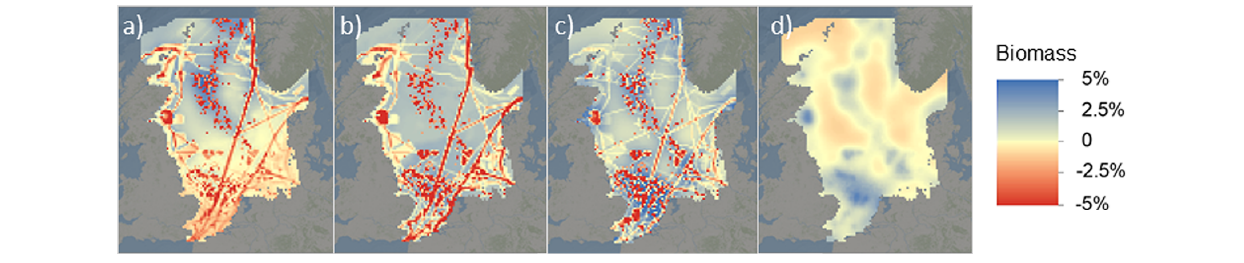
Fig. 6. North Sea biomass distribution and intensity changes up to 5% in response to the introduction of marine spatial planning start-up pressures after a 40-yr simulation period for various compartments. (A)